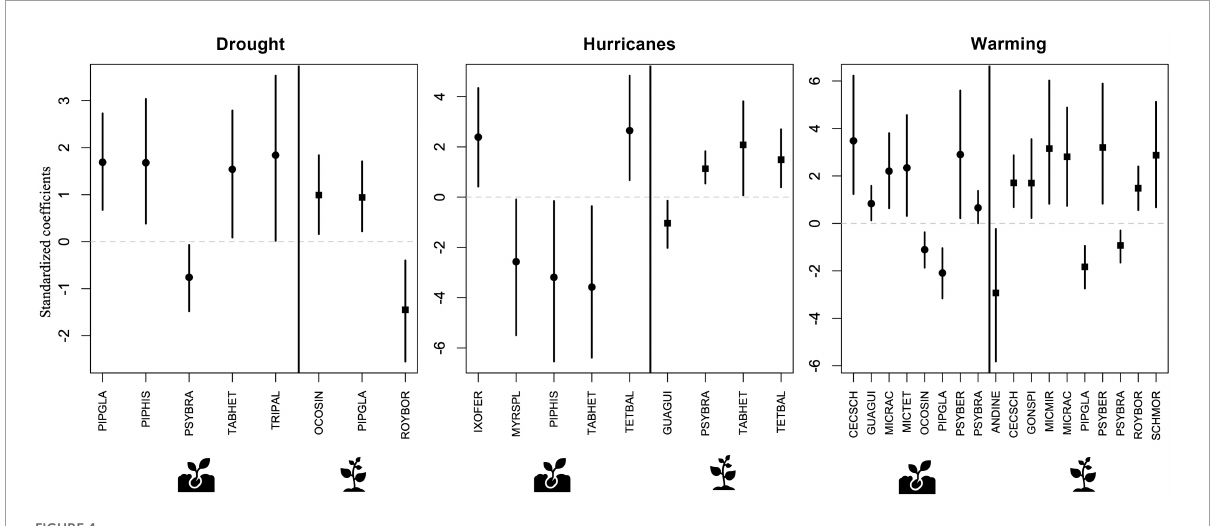
FIGURE4 Results of predictive trait modeling, showing species with abundances that were significantly associated with each disturbance type at the seedling (circles) and sapling (squares) ontogenetic stages. In each plot, the vertical solid line separates seedlings from saplings. Lines expand to the 95% credible intervals. Full species name, life form, and successional status can be found on Table 2 .